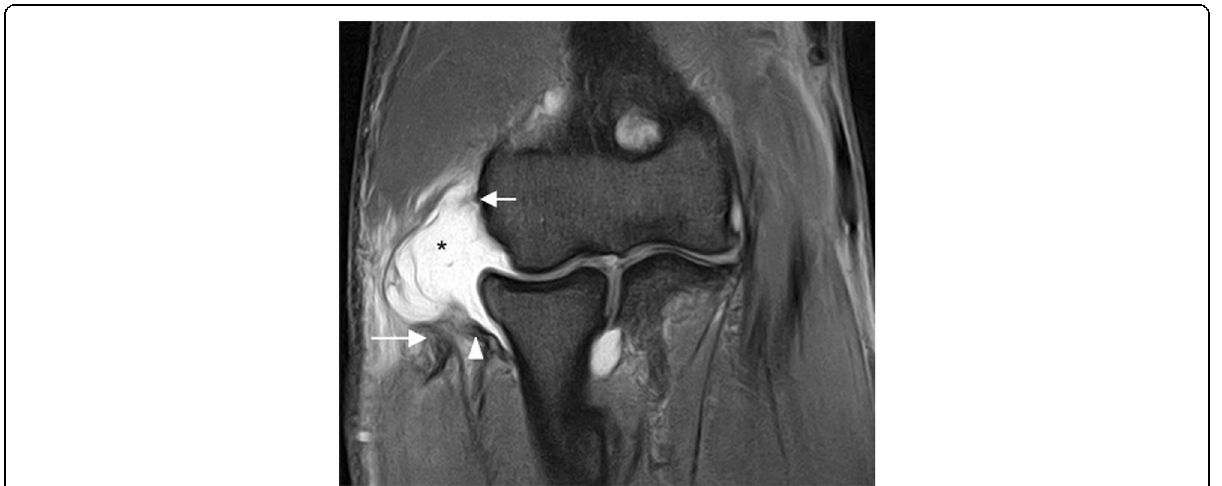
Fig. 24 Posterolateral rotatory instability, stage 2. Coronal FS PD-weighted MRI showing a complete detachment of the proximal lateral ulnar collateral ligament, the proximal radial collateral ligament proper, and the common extensor tendon (white short arrow), with retraction of the lateral ulnar collateral ligament (white arrowhead) and common extensor tendon (long white arrow). Note the extravasation of the joint fluid through the tear (black asterisk)